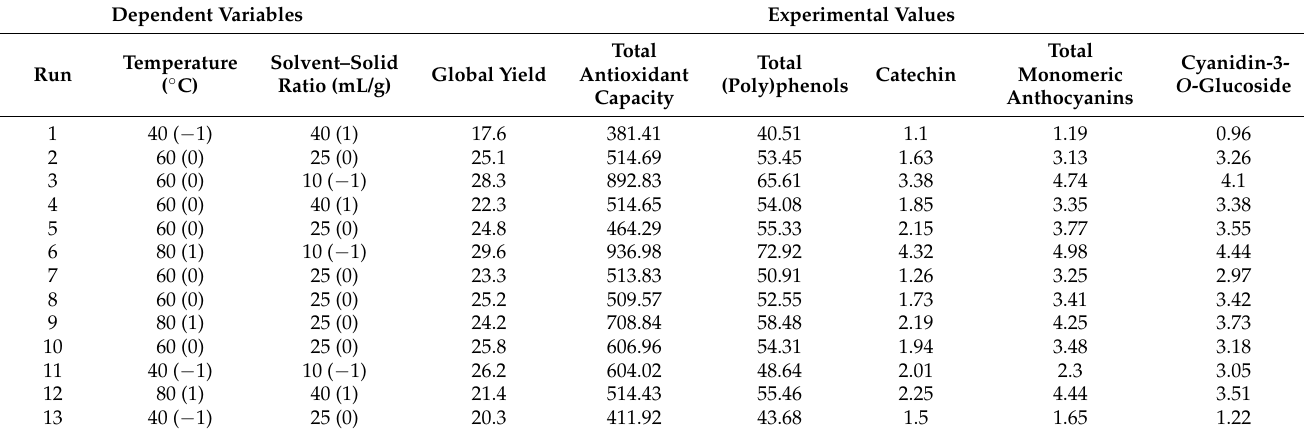
Table 2. Experimental conditions and results of PHWE on global yield, total antioxidant capacity, total (poly)phenols, catechin, total monomeric anthocyanins, and cyanidin-3- O -glucoside in black rosehip fruit, dry